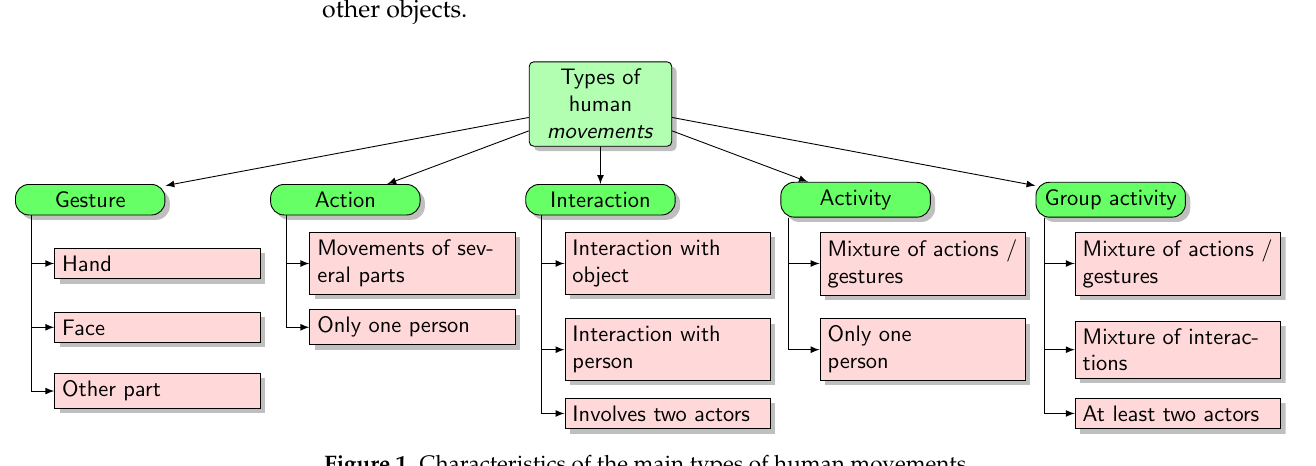
Figure 1. Characteristics of the main types of human